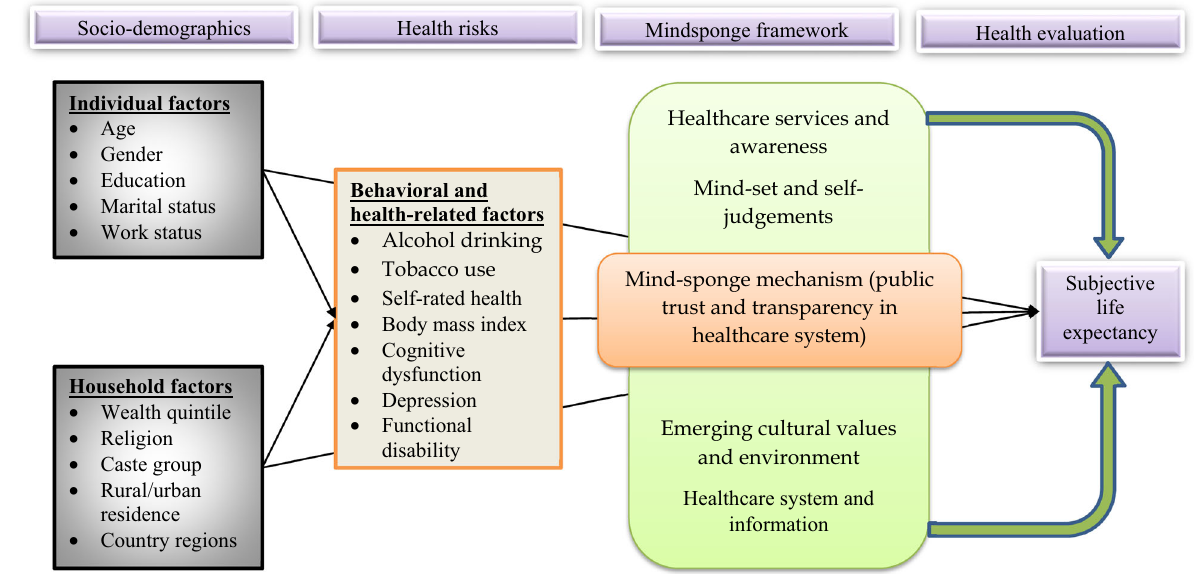
Fig. 1 Conceptual framework for the study. Summary of the framework that incorporates the mindsponge mechanism in association with